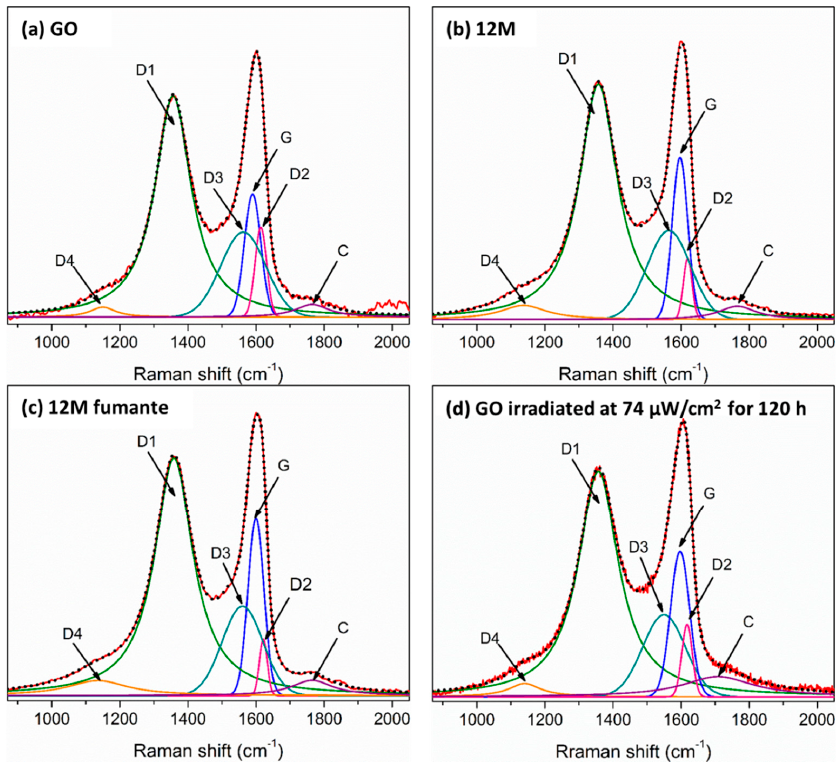
Figure 4. Raman spectroscopy spectra of ( a ) as-produced GO, ( b ) RGO treated with H 2 SO 4 in 12 M concentration, ( c ) RGO treated with fuming H 2 SO 4 in 12 M concentration, and ( d ) RGO irradiated at 74 µ W/cm 2 for 120 h. The ratio between the intensity of the D and G bands (I D /I G ) was also calculated since it is generally used to measure structural disorder. The I D /I G ratio decreased